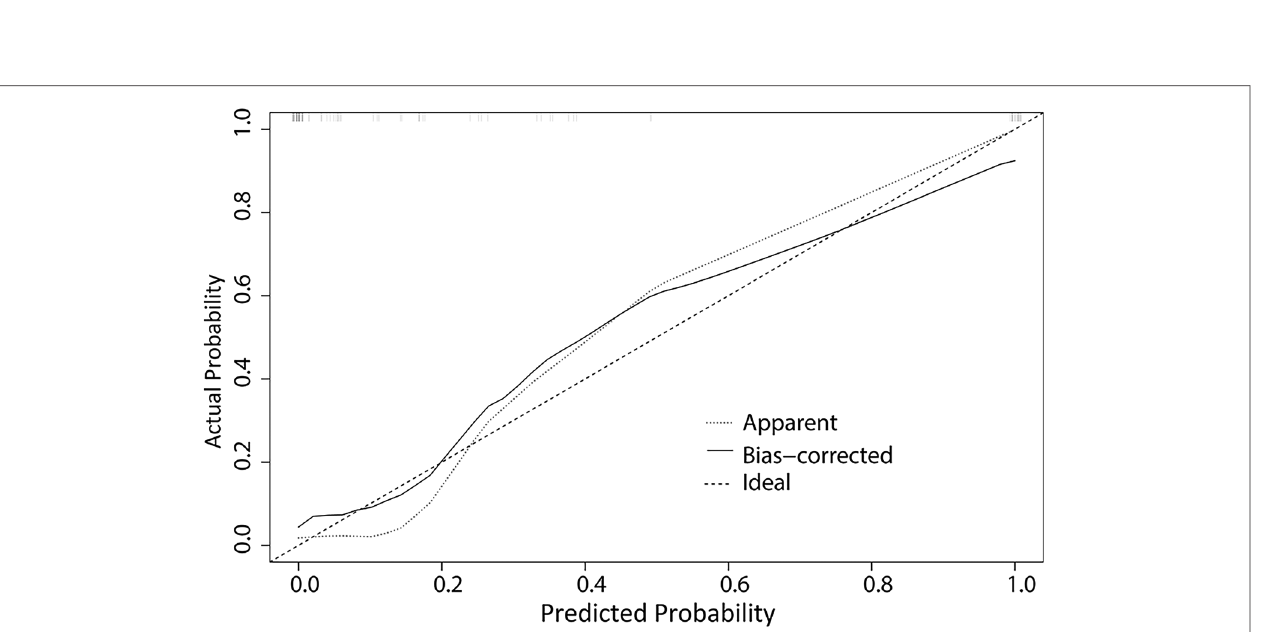
FIGURE 4 | The external validation curve for the nomogram of pathologic complete response after neoadjuvant chemotherapy in breast cancer